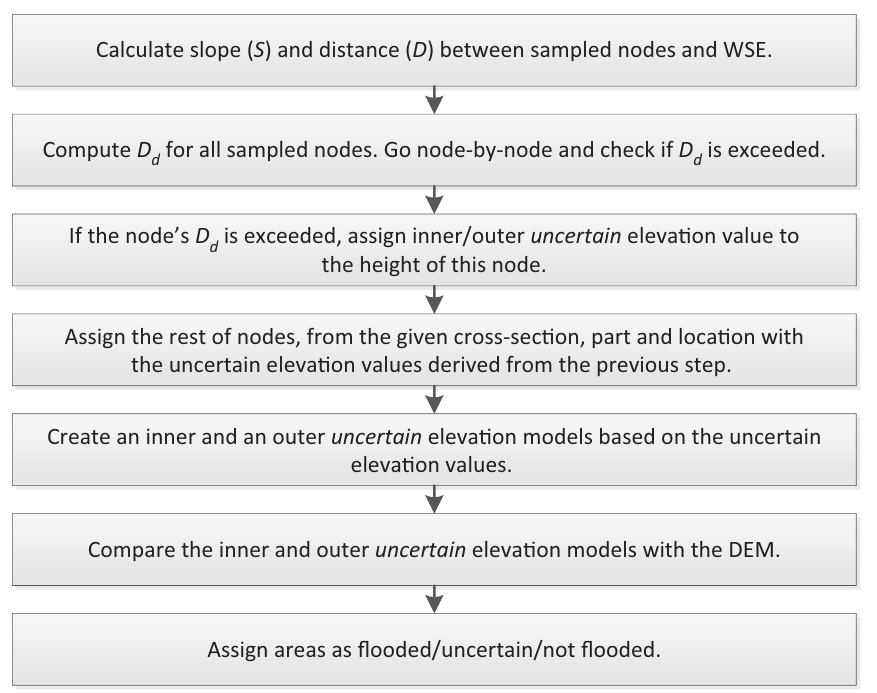
Figure 2. A simplified workflow of the D